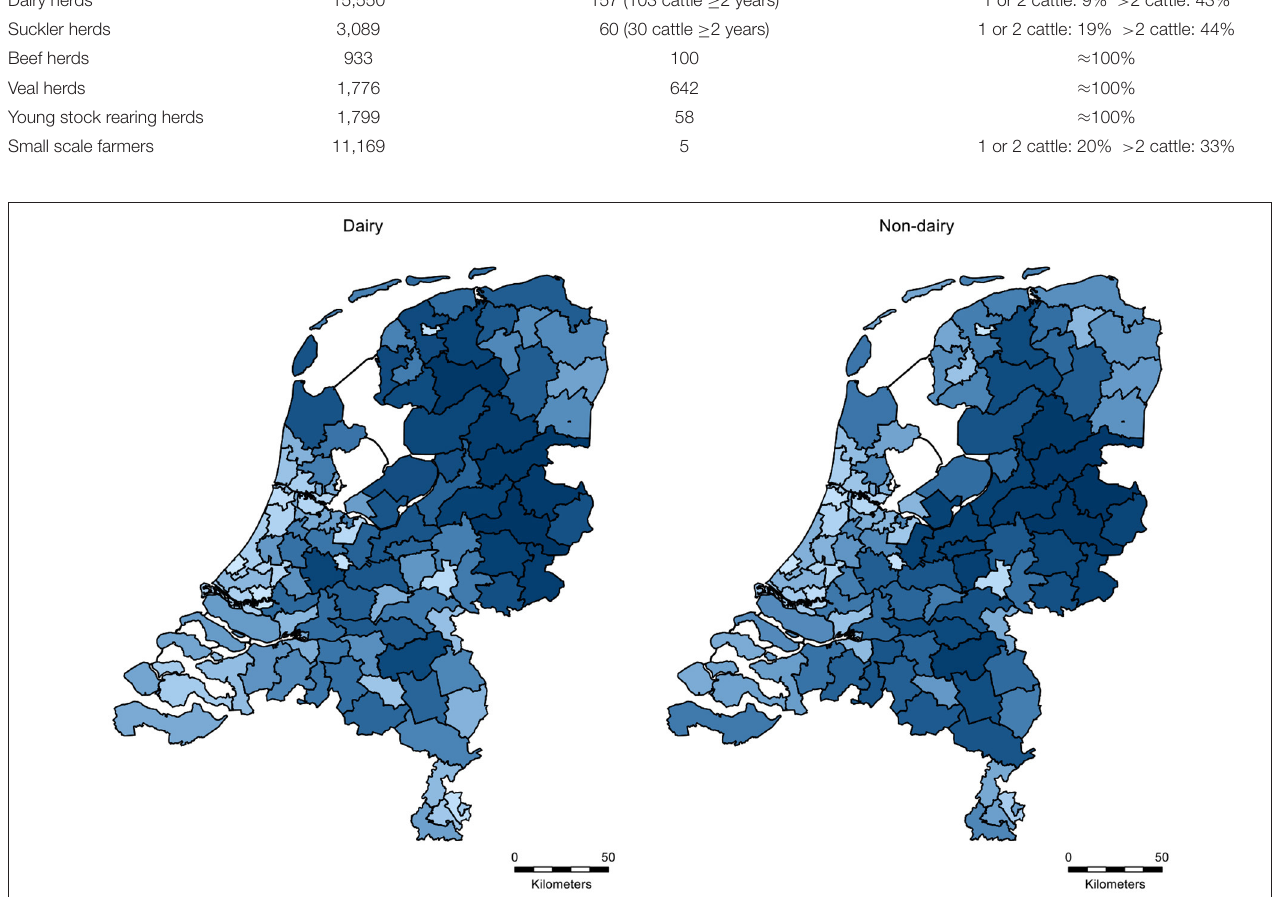
FIGURE 7 | Distribution of the density of dairy and non-dairy herds per 2-digit postal code area in the Netherlands in 2019. Light blue indicates a low herd density and dark blue indicates a high herd density.